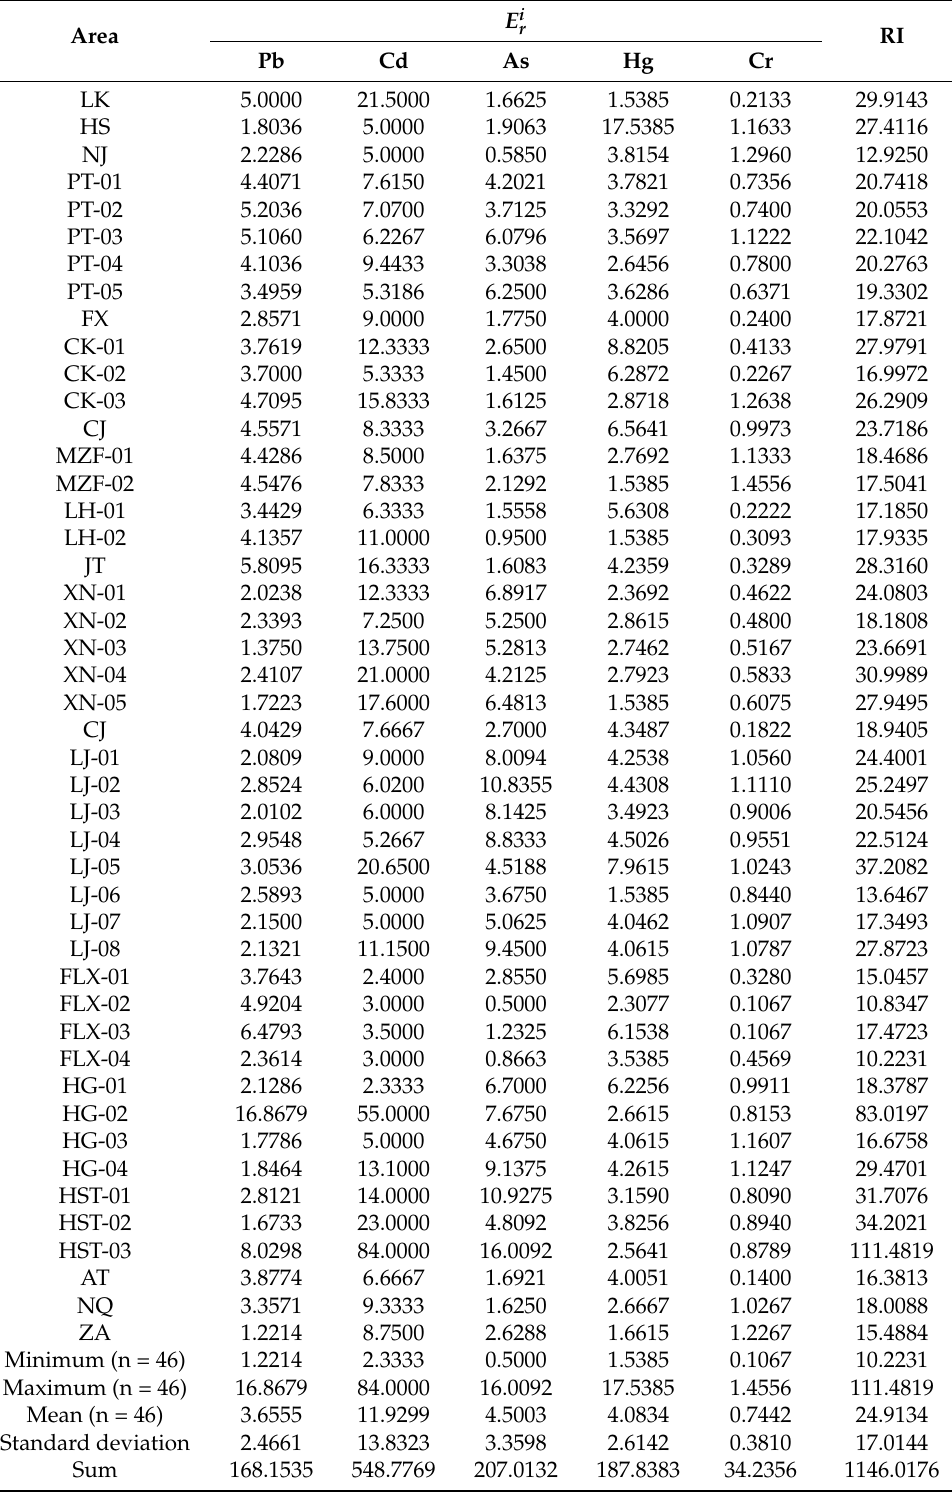
Table 5. The E i r and RI levels of five metals in bamboo shoots soil of the research